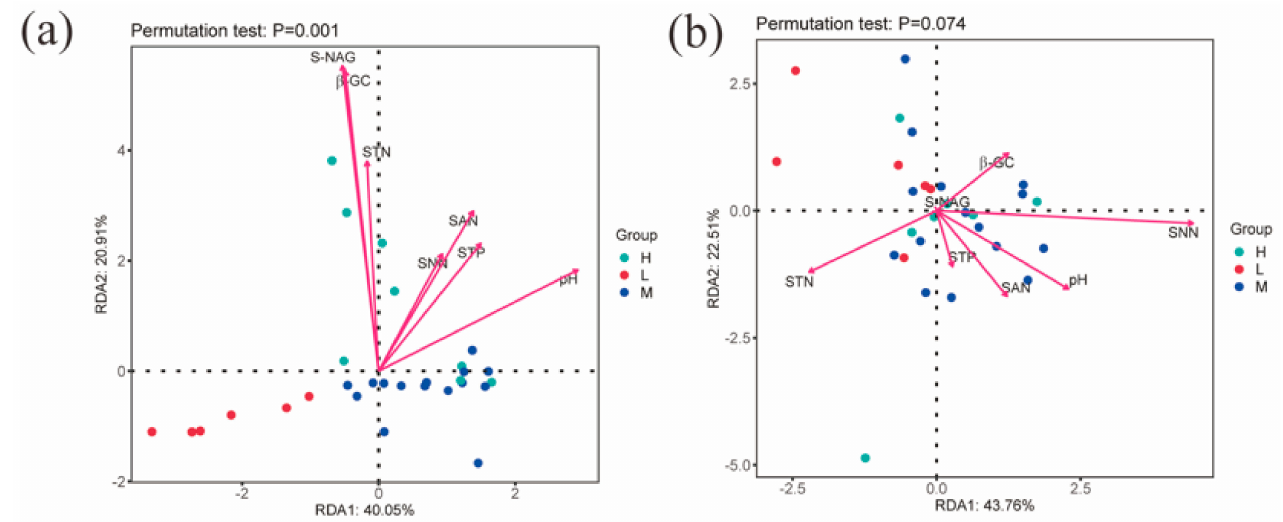
Figure 6. Redundancy analysis of soil factors and microbial community composition. Note: ( a ) indicates the RDA analysis of environmental factors and soil bacterial communities; ( b ) in- dicates the RDA analysis of environmental factors and soil fungal communities; S-NAG indicates N-acetyl- β -D-glucosidase, β -GC indicates β -glucosidase, STN indicates total nitrogen, SNN indicates nitrate nitrogen, SAN indicates ammonium nitrogen, and STP indicates total phosphorus; H, M and L denote high, medium and low water-salt gradients,